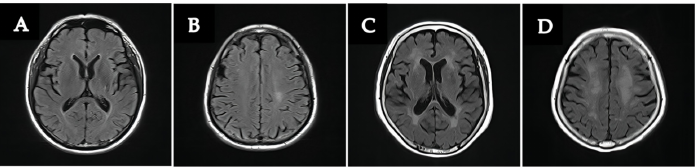
Figure 3. The T2-FLAIR sequence of two typical patients who had heterogeneity between WMH severity and cognition. Case 1: A 51-year-old male patient presented with mild WMHs ( A , B ) but had cognitive impairment with MOCA score of 20 (years of education: 12); Case 2: A 60-year-old female patient had normal cognition but severe WMHs ( C , D ). The MOCA score was 26 (years of education: